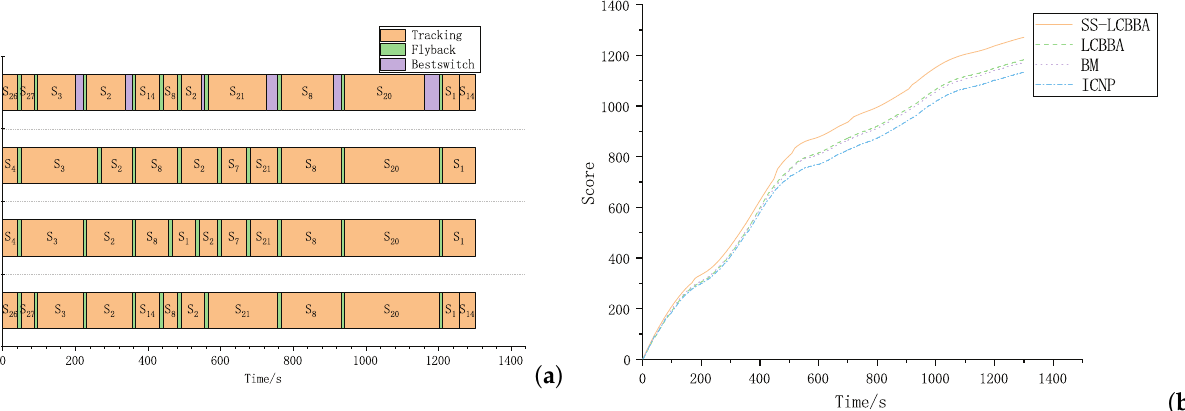
Figure 15. The planning results of tracking trajectory 3: ( a ) is a Gantt chart comparing the planning results and ( b ) is the cumulative tracking score of the value